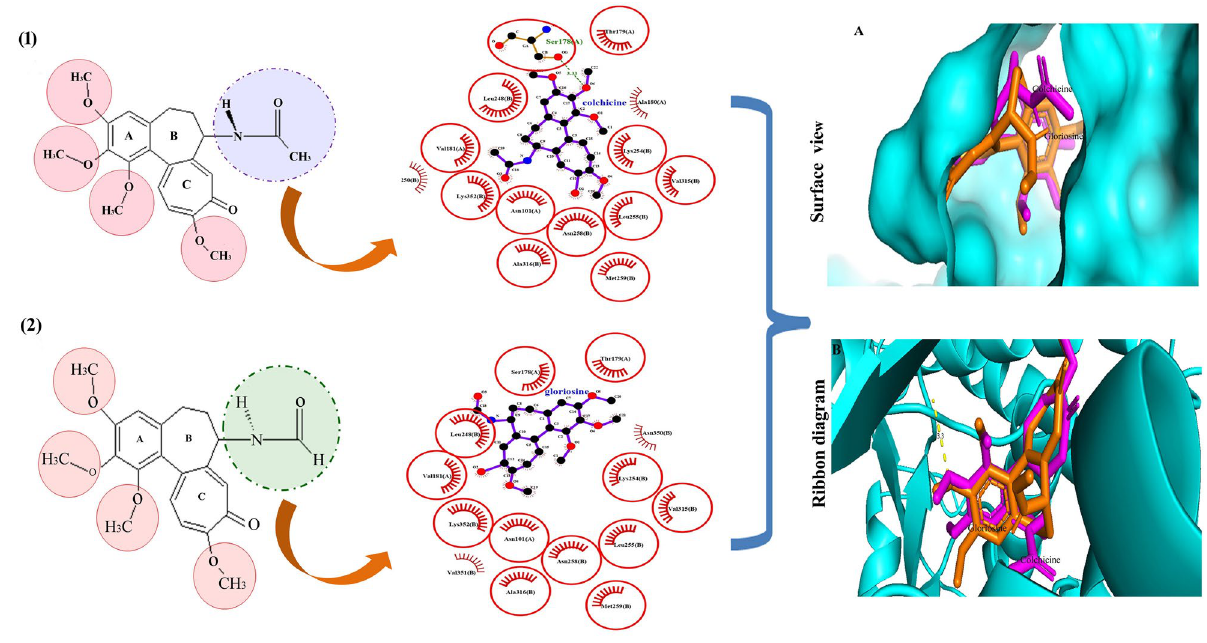
Figure 1. In silico interactions of colchicine and gloriosine at CBS. The chemical structure of colchicine ( 1 ) and gloriosine ( 2 ). The Interactions of docked ligands (2D plot) of colchicine ( 1 ), and gloriosine ( 2 ) with tubulin protein (1sa0), generated by Ligplot +. Overlapped docking of gloriosine with co-crystallized colchicine in CBS of β-tubulin protein (1sa0). The overlapping was represented from two different sides, i.e. surface view ( A ) and ribbon view ( B ), wherein, gloriosine and colchicine is represented by orange and magenta colour respectively. The enlarged Ligplot + image of colchicine and gloriosine is shown in Supplementary Fig. 1A,B